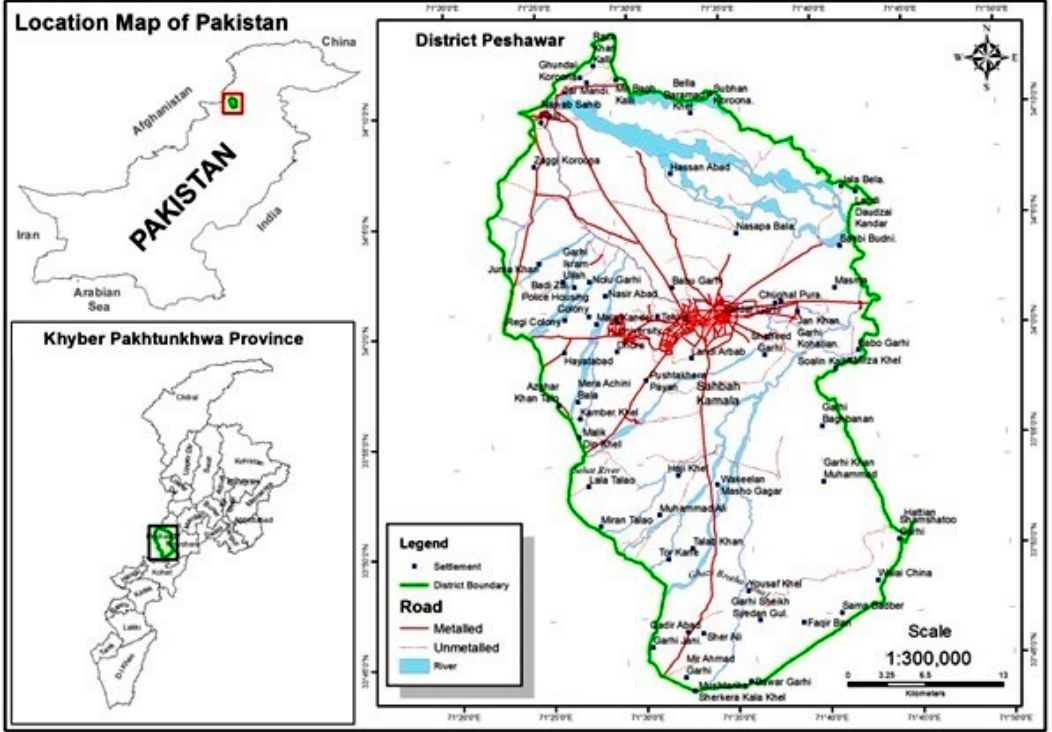
Figure 1. Location map of study area, Peshawar.